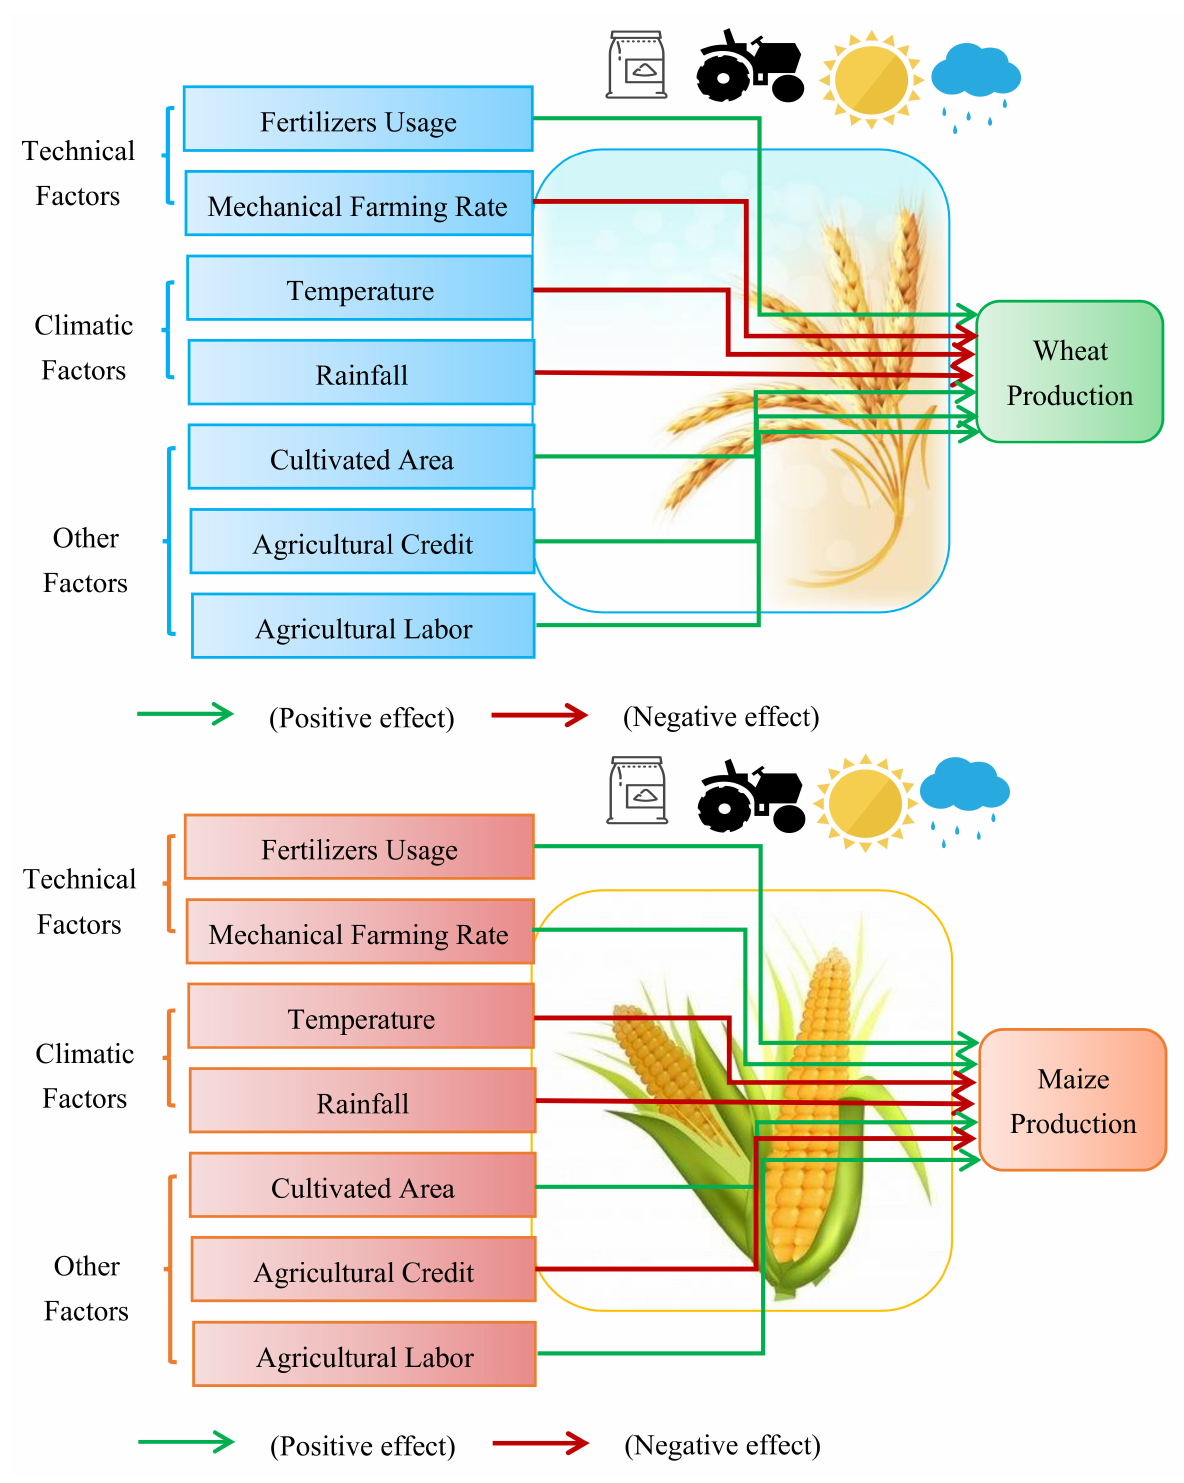
Figure 6. Key findings for Models 1, 2, and